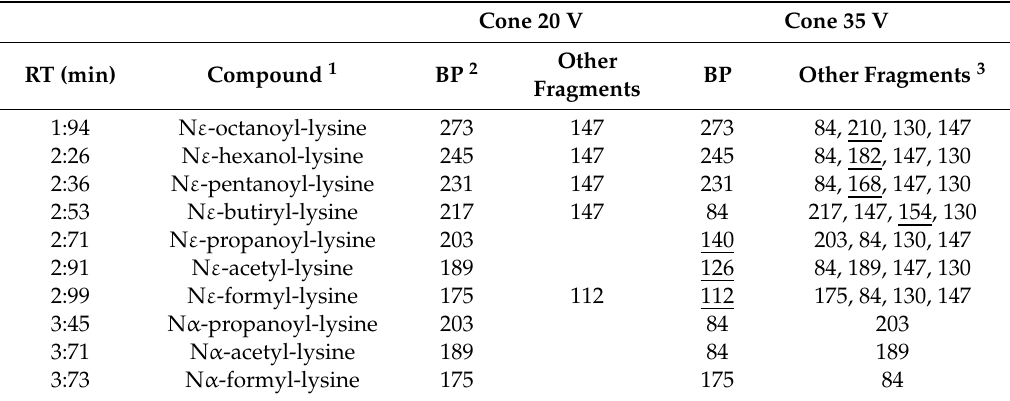
Table 1. Lysine adducts with n-alkanals, identified by LC–MS in the aqueous extracts of the RSO + 2LYS sample throughout the oxidation process, together with their retention times (RT), mass spectra base peaks (BP), and other fragments of their mass